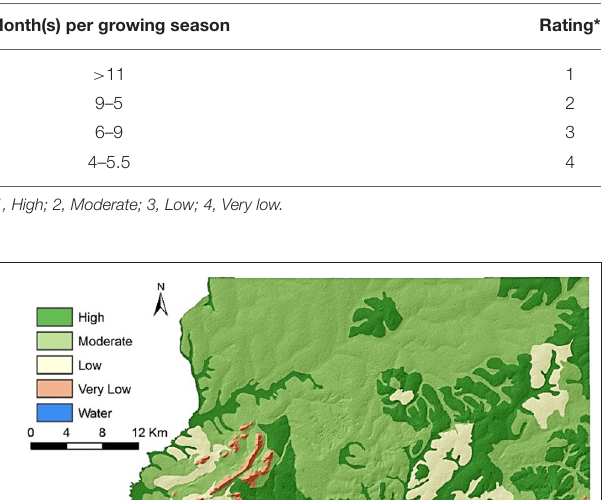
TABLE 6 | Ratings for the availability of moisture for plant growth [Table 14 in (42)].